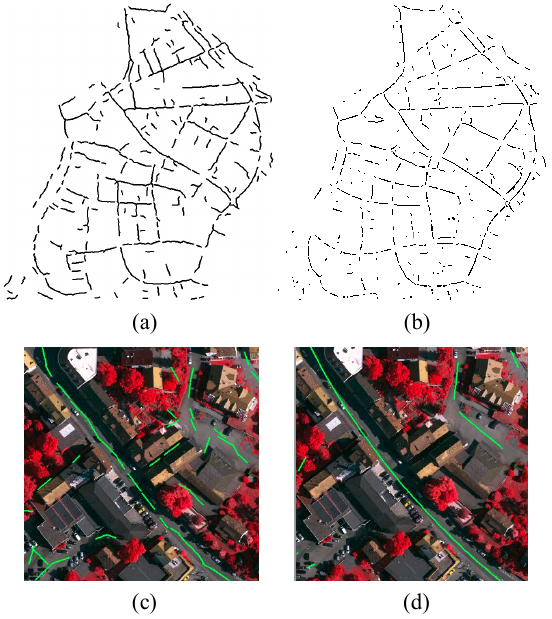
Figure 3. (a) Road primitives detected by our method(MLF).(b) Road primitives detected by MTH.(c) Primitives in local area detected by MLF.(d) Primitives in local area detected by MTH.